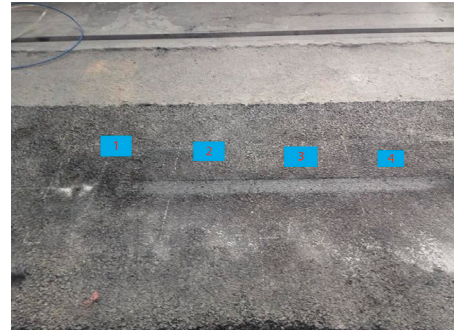
Figure 10: Measurement locations for PSPA.